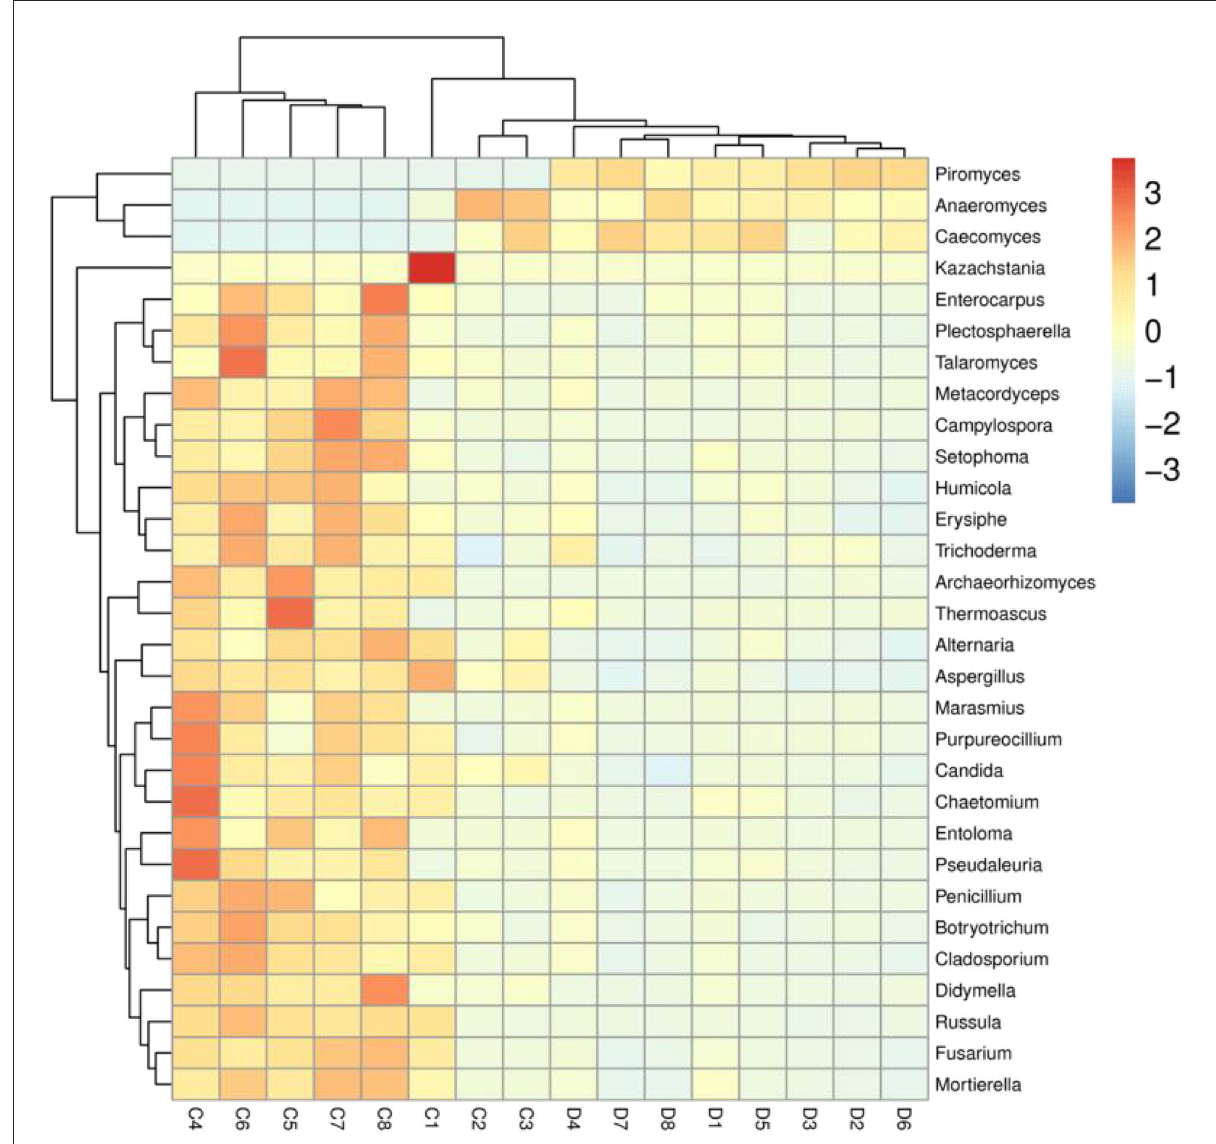
FIGURE4 Heatmap of the most abundant fungal genera in both groups. The values of color in the heat map indicate the normalized relative richness of species. C and D represent healthy and diarrheic groups, respectively.